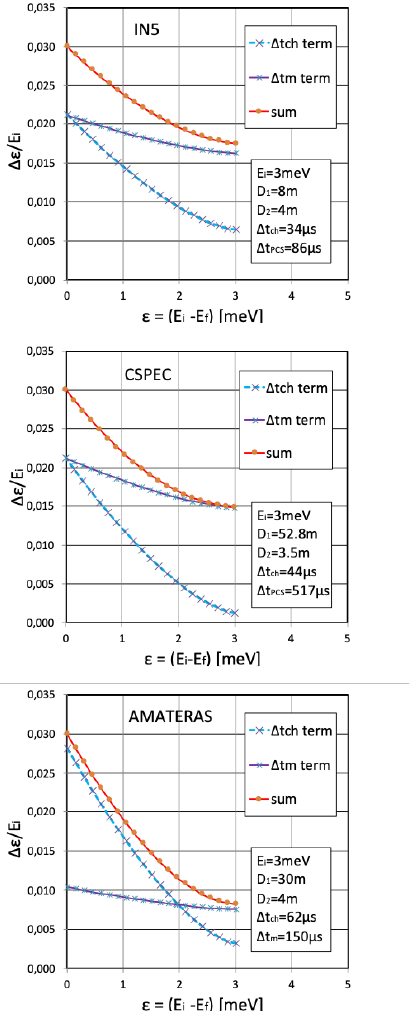
Fig. 5. Lechner's optimization; Energy resolution diagram for CSPEC, AMATERAS and IN5, where Δε /Ei is kept at 3% at the elastic position. In each panel, the first term with ( Δ tch), the second term with ( Δ tm/PSC) in Eq. (8) and the sum of them are depicted.